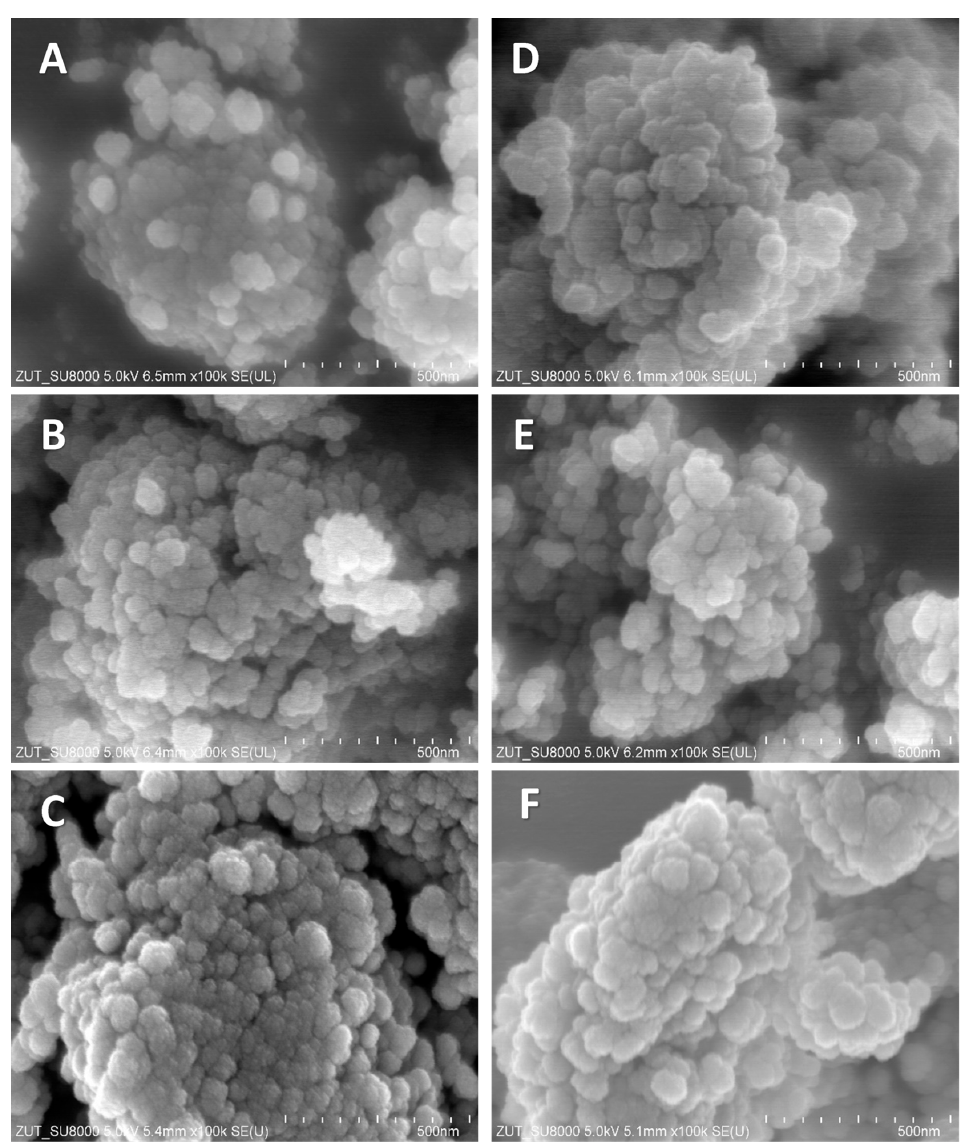
Figure 8. SEM images of TiO 2 prepared in Ar at ( A ) 400 °C, ( B ) 500 °C, ( C ) 600 °C and at H 2 ( D ) 450 °C, ( E ) 500 °C, ( F ) 600 °C, magnification × 100 k.